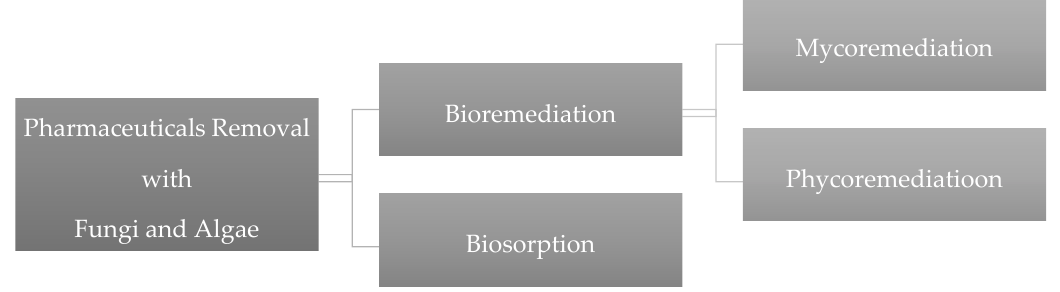
Figure 2. Mechanisms of pharmaceutical removal with fungi and algae.